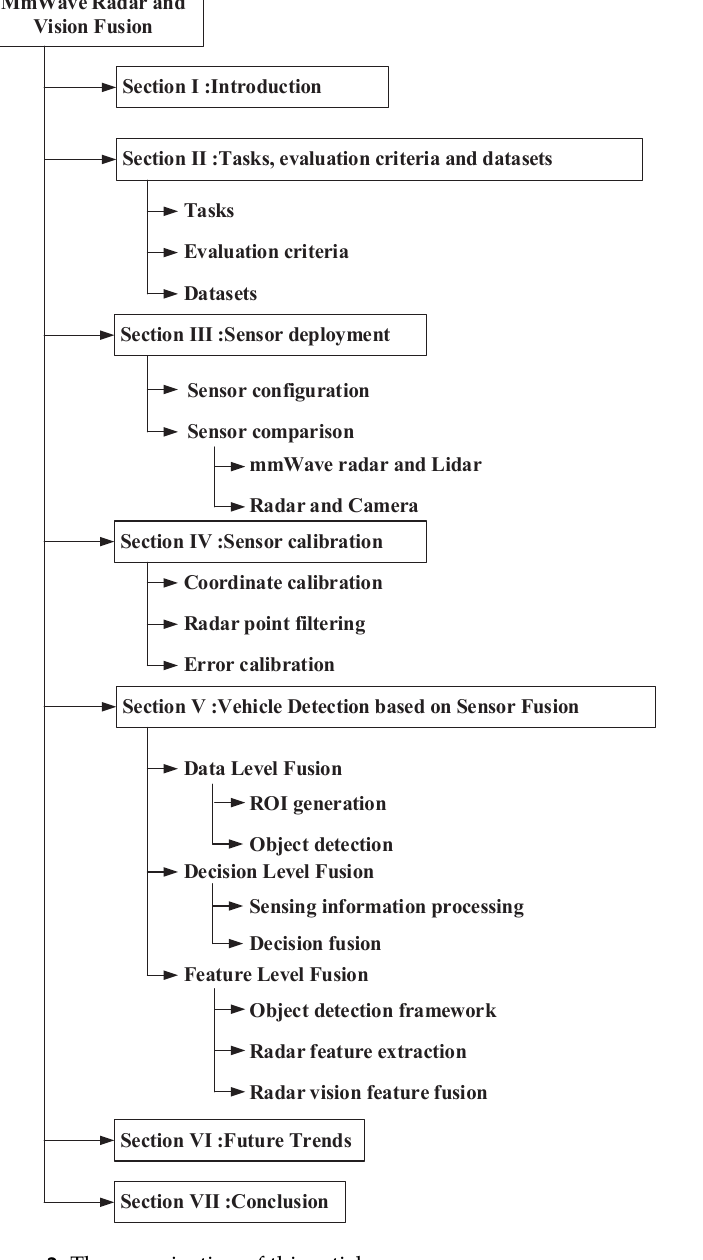
Figure 2. The organization of this